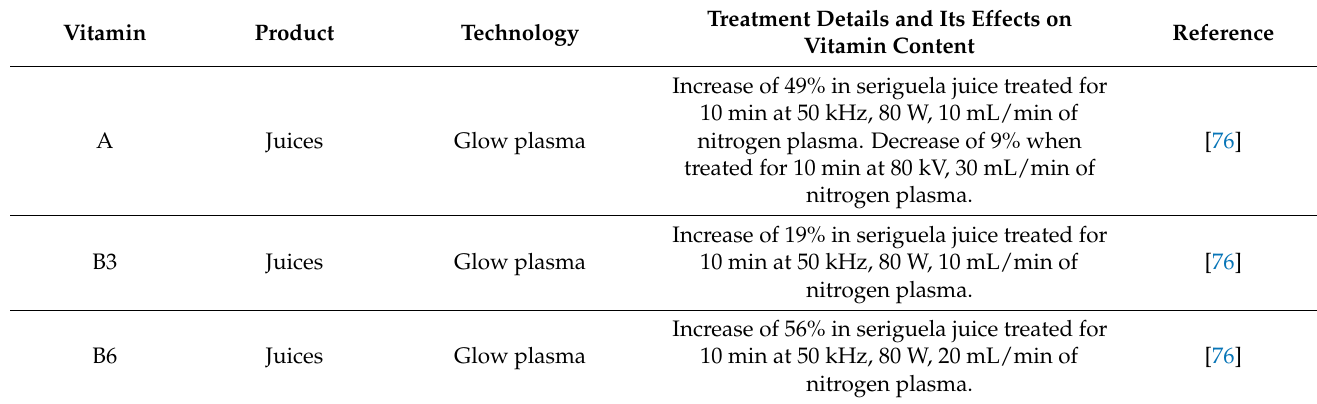
Table 3. Changes in vitamins A, B3, and B6 induced by cold plasma application. Treatment Details and Its Effects